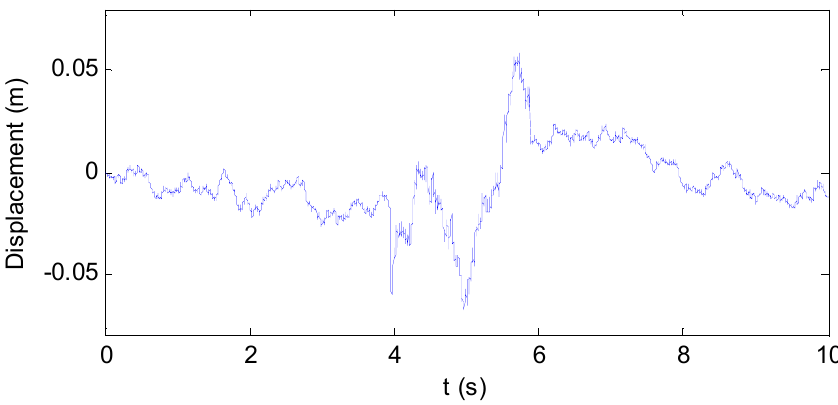
17 of 21 Figure 18. Comparison of the tire dynamic loads using the three control methods under C class road excitation.